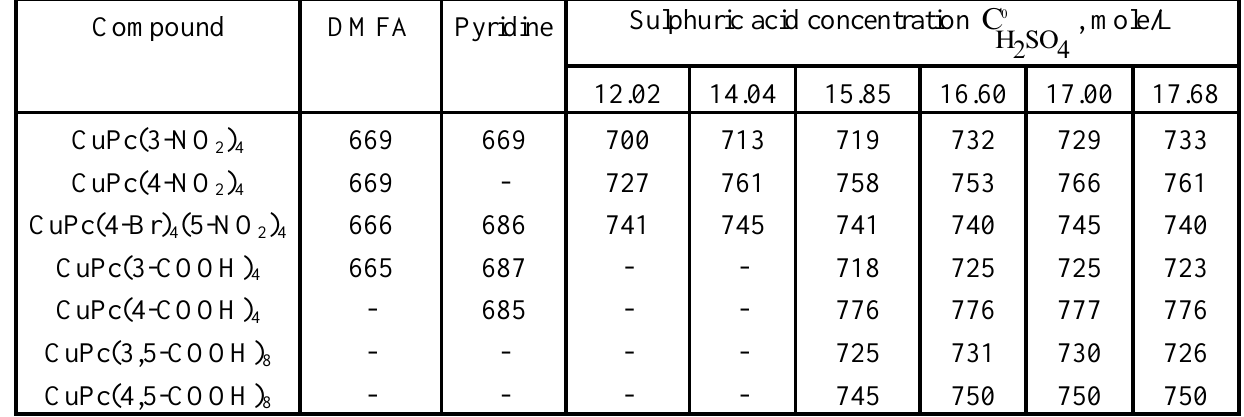
Table 1. Position of the low energy maximum of the Q(0,0) band in the UV-vis spectra of , nm). copper(II)phthalocyanines ( l max